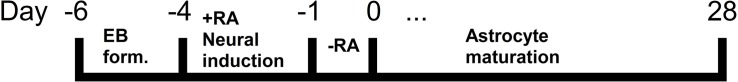
Schematic representation of the protocol used for the differentiation of mouse embryonic stem cell lines (mESCs) into astrocytes over a total time of 2–5 weeks. Mouse ESCs were used to generate embryoid bodies (EBs), which were seeded onto laminated glass coverslips. Migrating astrocytes were detected and labeled from DIV 7 to DIV 28.